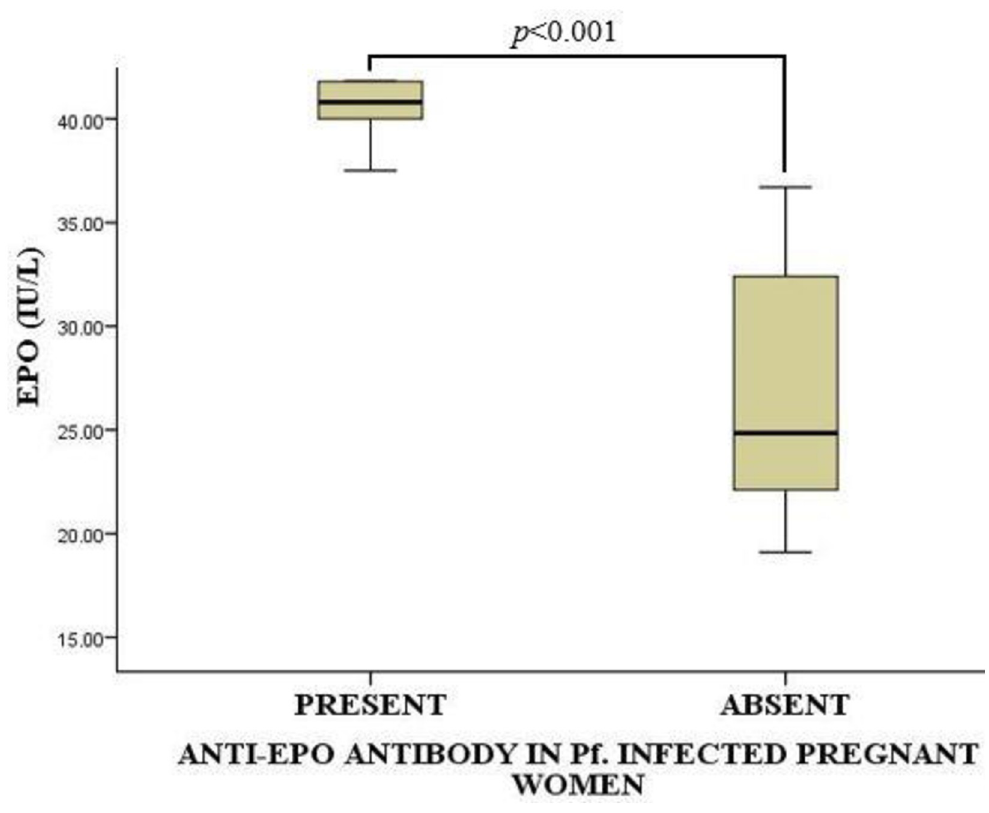
Fig 5. Serum erythropoietin levels of the P . falciparum- infected pregnant women stratified by the presence or absence of serum anti-erythropoietin antibodies. EPO = Erythropoietin; IU/L = International Unit per Litre. Data were compared using Mann Whitney U-Test. p < 0.05 was considered